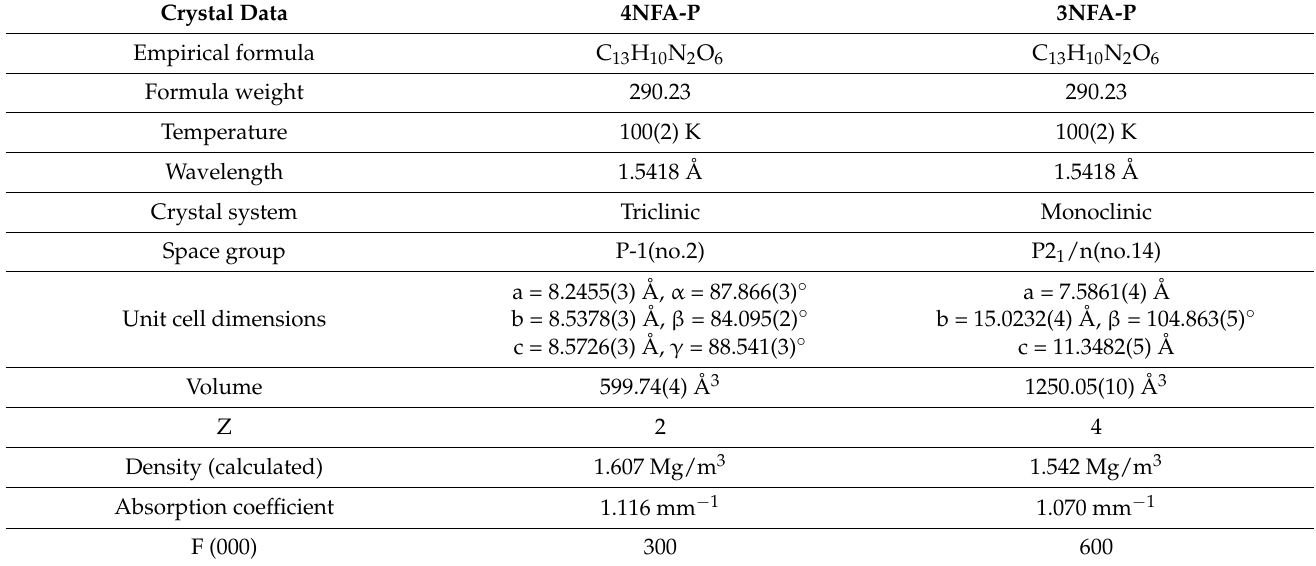
Table A1. Crystal data and structure refinement for 3-nitrophthalic acid with pyridine ( 3NFA-P ) and 4-nitrophthalic acid with pyridine ( 4NFA-P